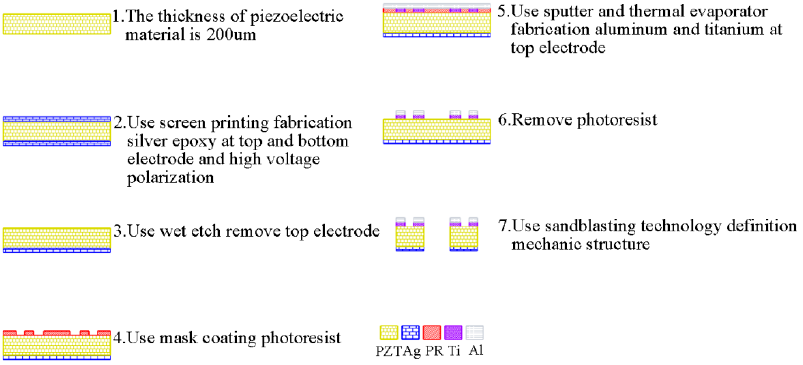
Figure 12. Microfabrication process of the proposed PZT gyroscope design.